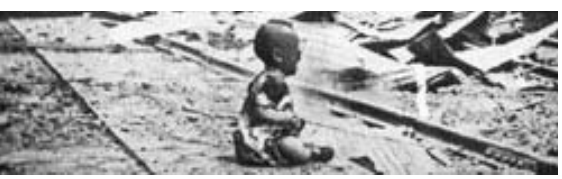
Figure 3. Baby Ping-Mei. Source: LOOK Magazine.